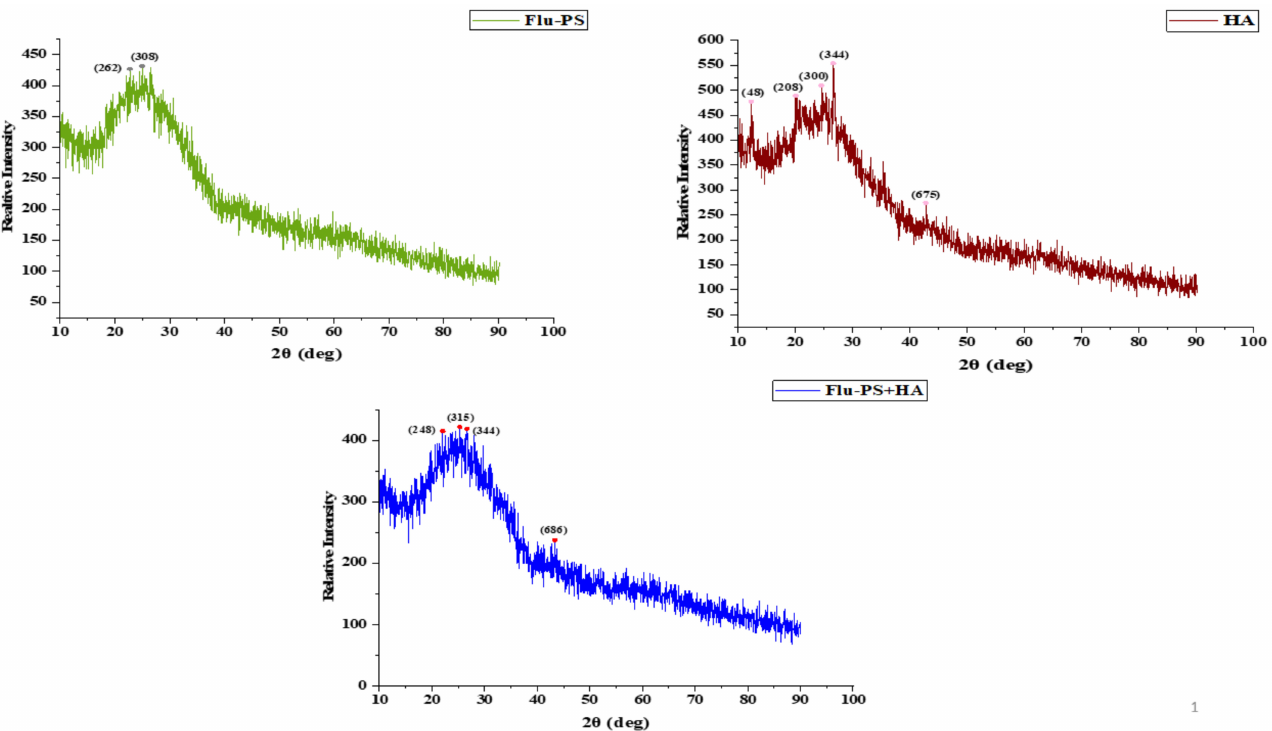
Figure 4. XRD observation patterns: Flu − PS, HA, and Flu −